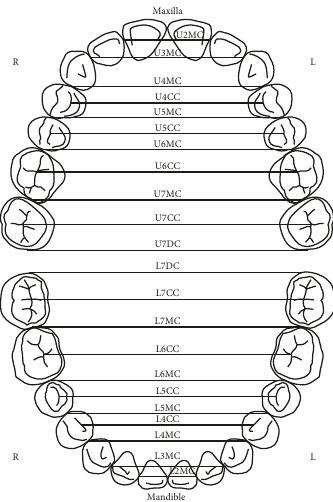
Figure 3: Illustration of the maxillary and mandibular arches’ widths as described by Ling and Wong [9]. U2MC: contact points between tooth 11 and tooth 12 and tooth 21 and tooth 22; U3MC: contact points between tooth 12 and tooth 13 and tooth 22 and tooth 23; U4MC: contact points between tooth 13 and tooth 12 and tooth 23 and tooth 22; U4CC: central fossa of tooth 14 and tooth 24; U5MC: contact points between tooth 14 and tooth 15 and tooth 24 and tooth 25; U5CC: central fossa of tooth 15 and tooth 25; U6MC: contact points between tooth 15 and tooth 16 and tooth 25 and tooth 26; U5CC: central fossa of tooth 15 and tooth 25; U7MC: contact points between tooth 16 and tooth 17 and tooth 26 and tooth 27; U7CC: central fossa of tooth 17 and tooth 27; U7DC: estimated distal contact points between tooth 17 and tooth 18 and tooth 27 and tooth 28; L7DC: estimated distal contact points be- tween tooth 37 and tooth 38 and tooth 47 and tooth 48; L7CC: central fossa of tooth 37 and tooth 47; L7MC: contact points be- tween tooth 36 and tooth 37 and tooth 46 and tooth 47; L6CC: central fossa of tooth 36 and tooth 46; L6MC: contact points be- tween tooth 35 and tooth 36 and tooth 45 and tooth 46; L5CC: central fossa of tooth 35 and tooth 45; L5MC: contact points be- tween tooth 34 and tooth 35 and tooth 44 and tooth 45; L4CC: distal fossa of tooth 34 and tooth 44; L4MC: contact points between tooth 33 and tooth 34 and tooth 43 and tooth 44; L3MC: contact points between tooth 33 and tooth 32 and tooth 43 and tooth 44; L2MC: contact points between tooth 32 and tooth 31 and tooth 42 and tooth 41.